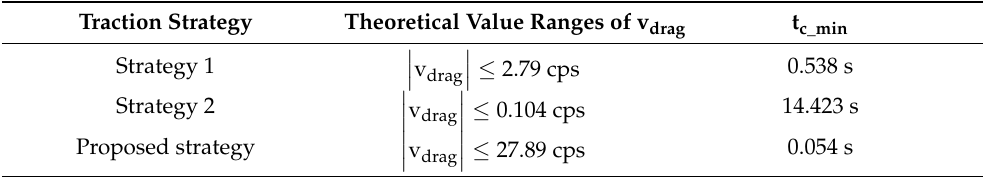
Table 3. Value ranges of v drag for three